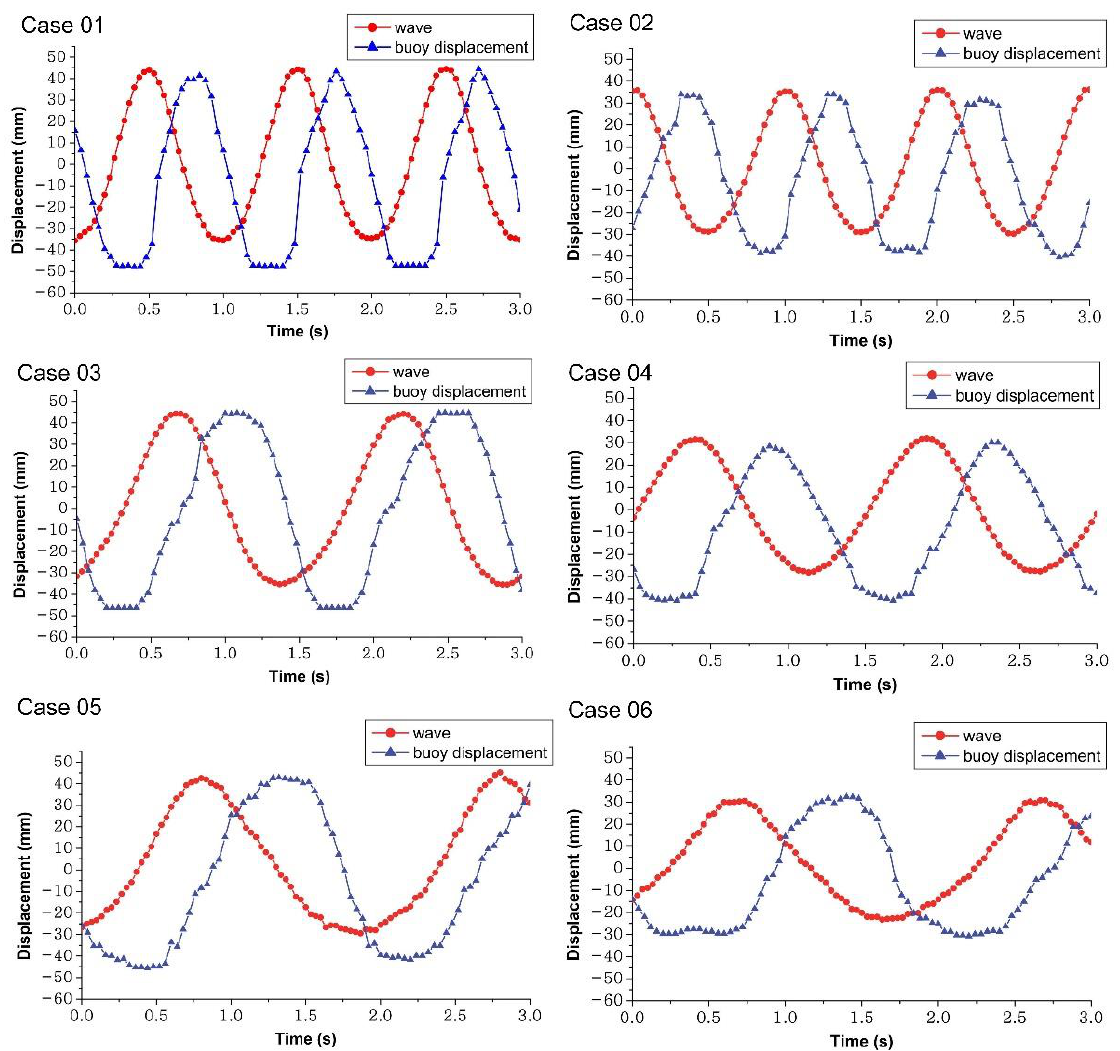
Figure 12. Wave height and the buoy displacement.